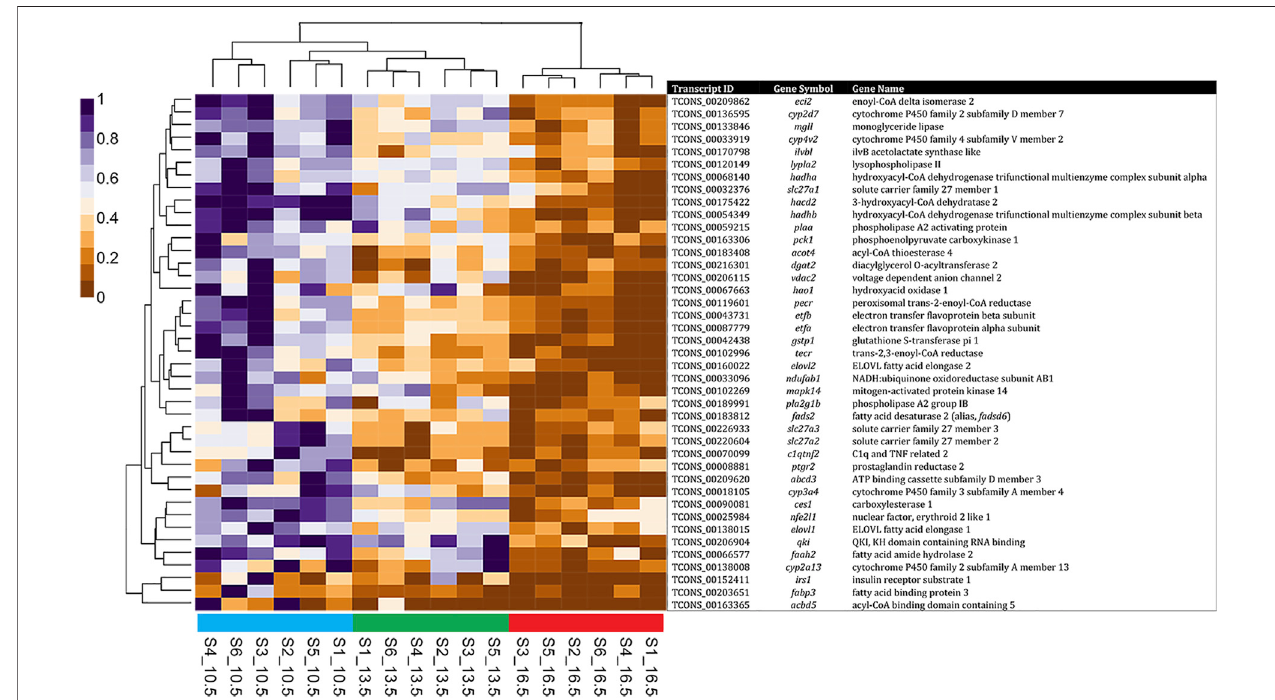
FIGURE 5 | Heatmap and hierarchical clustering of non-redundant differentially expressed transcripts (41 DETs) found in comparison of the 10.5 ° C and 16.5 ° C groups associated with GO: 0006631 — Fatty Acid Metabolic Process. RNA samples used in sequencing are labeled on the base of the fi gure, with standardized fragments per kilobase of transcript per million mapped reads (FPKM) values for each DET clustered along the vertical